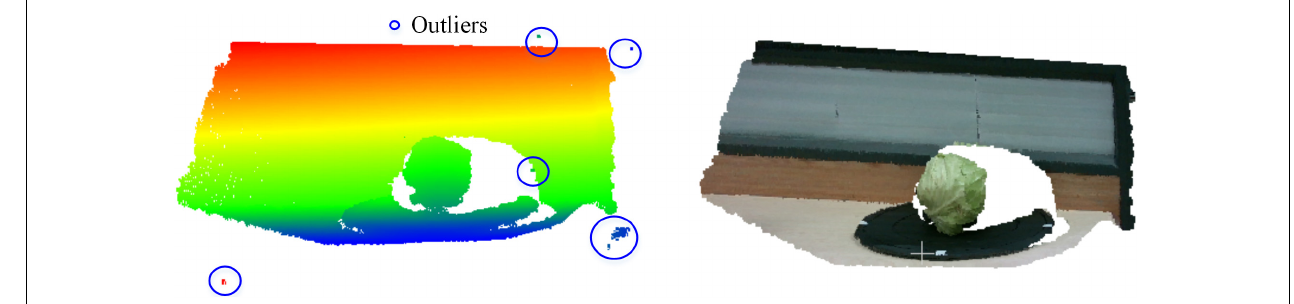
FIGURE 5 | Statistical filtering result of the point cloud.